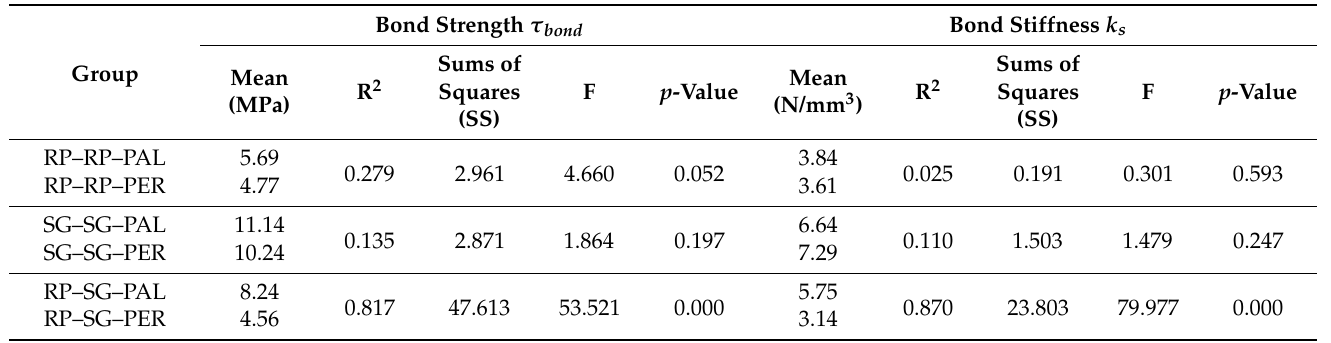
Table 4. Effects of bond direction on the shear bond strength and bond